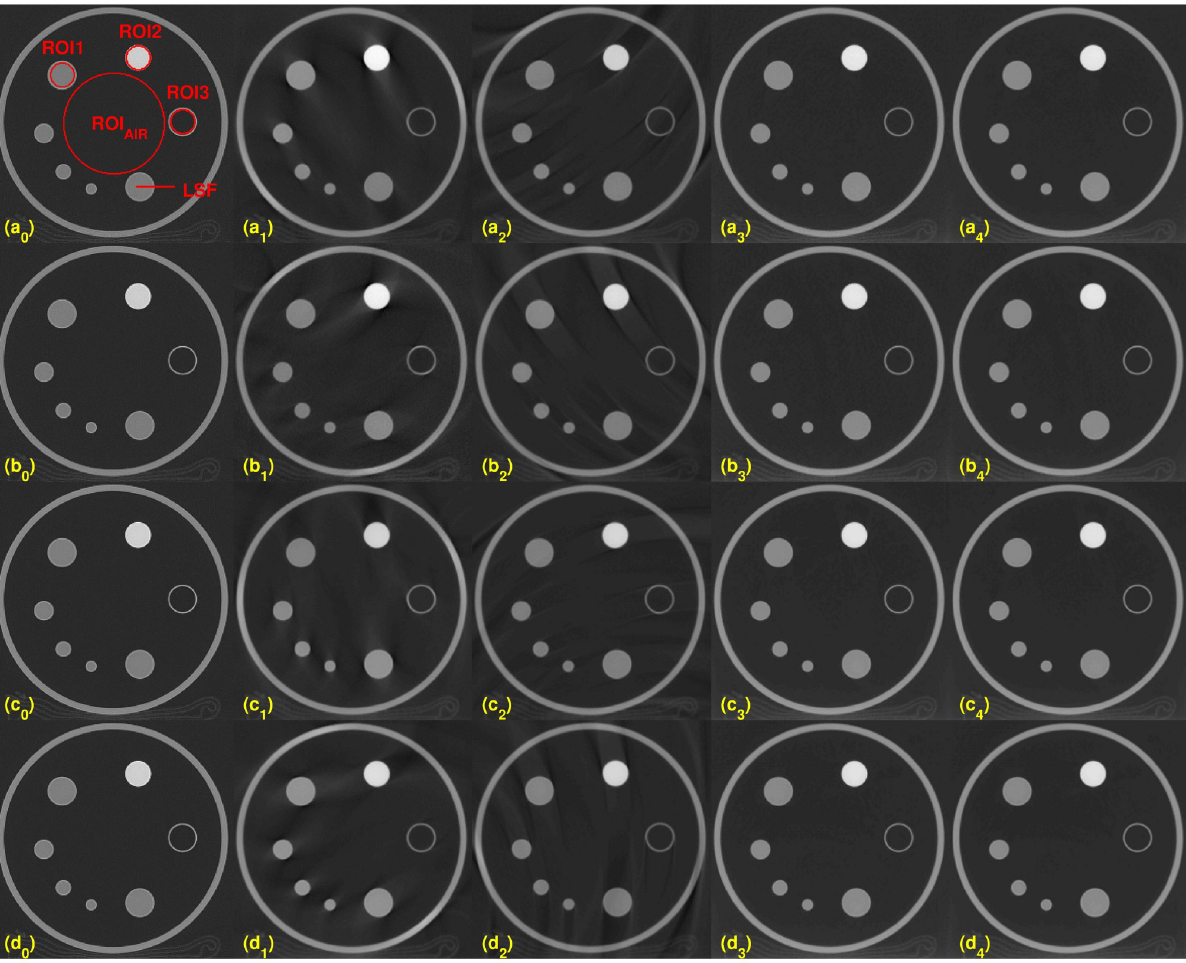
Fig 1. Illustrated reconstructed images with varying kVs on the slice number 10. (a 0 ): Image from the scanner. Red circles indicate ROI’s: ROI1, ROI2, ROI3 and ROI AIR . The red line is used to compute the LSF and MTF. Each row has reconstructed images at different kVs, (a j ): 80kV, (b j ): 100kV, (c ): 120kV, and (d ): 140 kV, for all j = 0 ��� 4. Each column has reconstructed images from different reconstruction algorithms: (X 0 ): scanner, (X 1 ): j j FDK, (X 2 ): Katsevich, (X 3 ): TV, and (X 4 ): TF for all letters X = a, b, c or d.